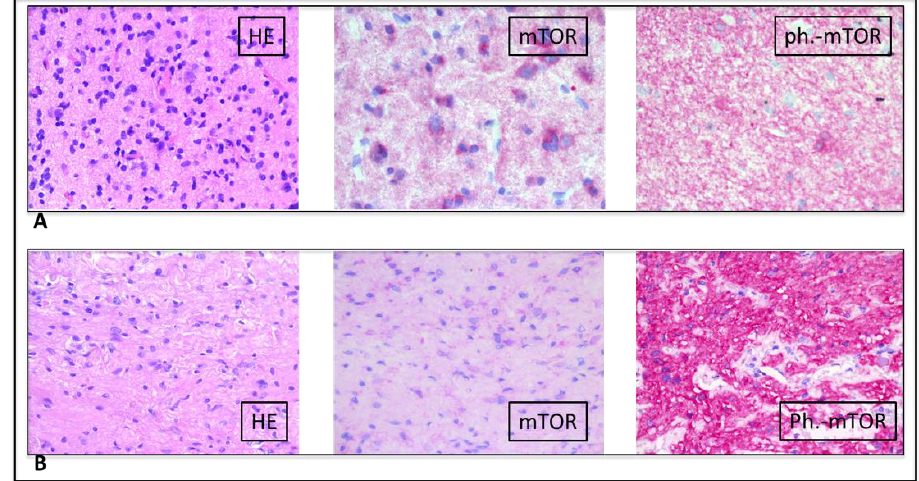
Figure 3. ( A ) (upper raw) (low-grade glioneural tumor): HE: Low intensity glial proliferation with intermingled few dysplastic ganglion cells. Mild nuclear atypia and low proliferation index. mTOR: mild cytoplasmic positivity of neoplastic cells. Phospho–mTOR: strong cytoplasmic positivity of neoplastic cells; ( B ) (lower raw) (pilocytic astrocytoma): HE: Pilocytic glial proliferation in a fibrillary background with evidence of some Rosenthal fibers. Mild nuclear atypia and low proliferation index. mTOR: mild cytoplasmic positivity of neoplastic cells. Phospho–mTOR: Strong cytoplasmic positivity of neoplastic cells.